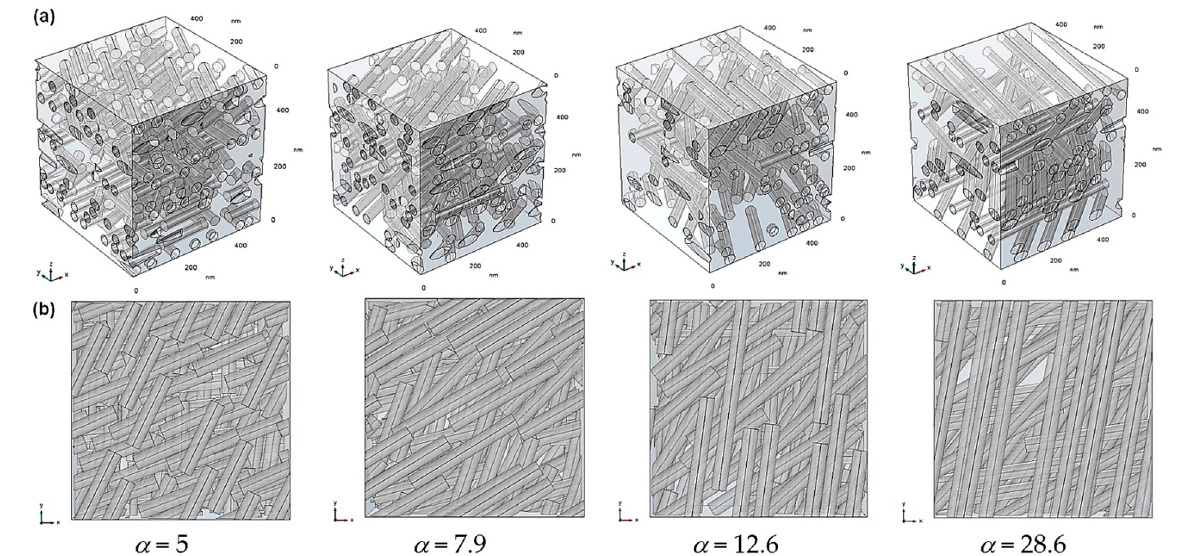
Figure 5. View of generated RVEs for several nanofiller aspect ratio values (monodisperse, volume fraction ≅ 22%): ( a ) isometric view; ( b ) projected view in the overall diffusion direction z .